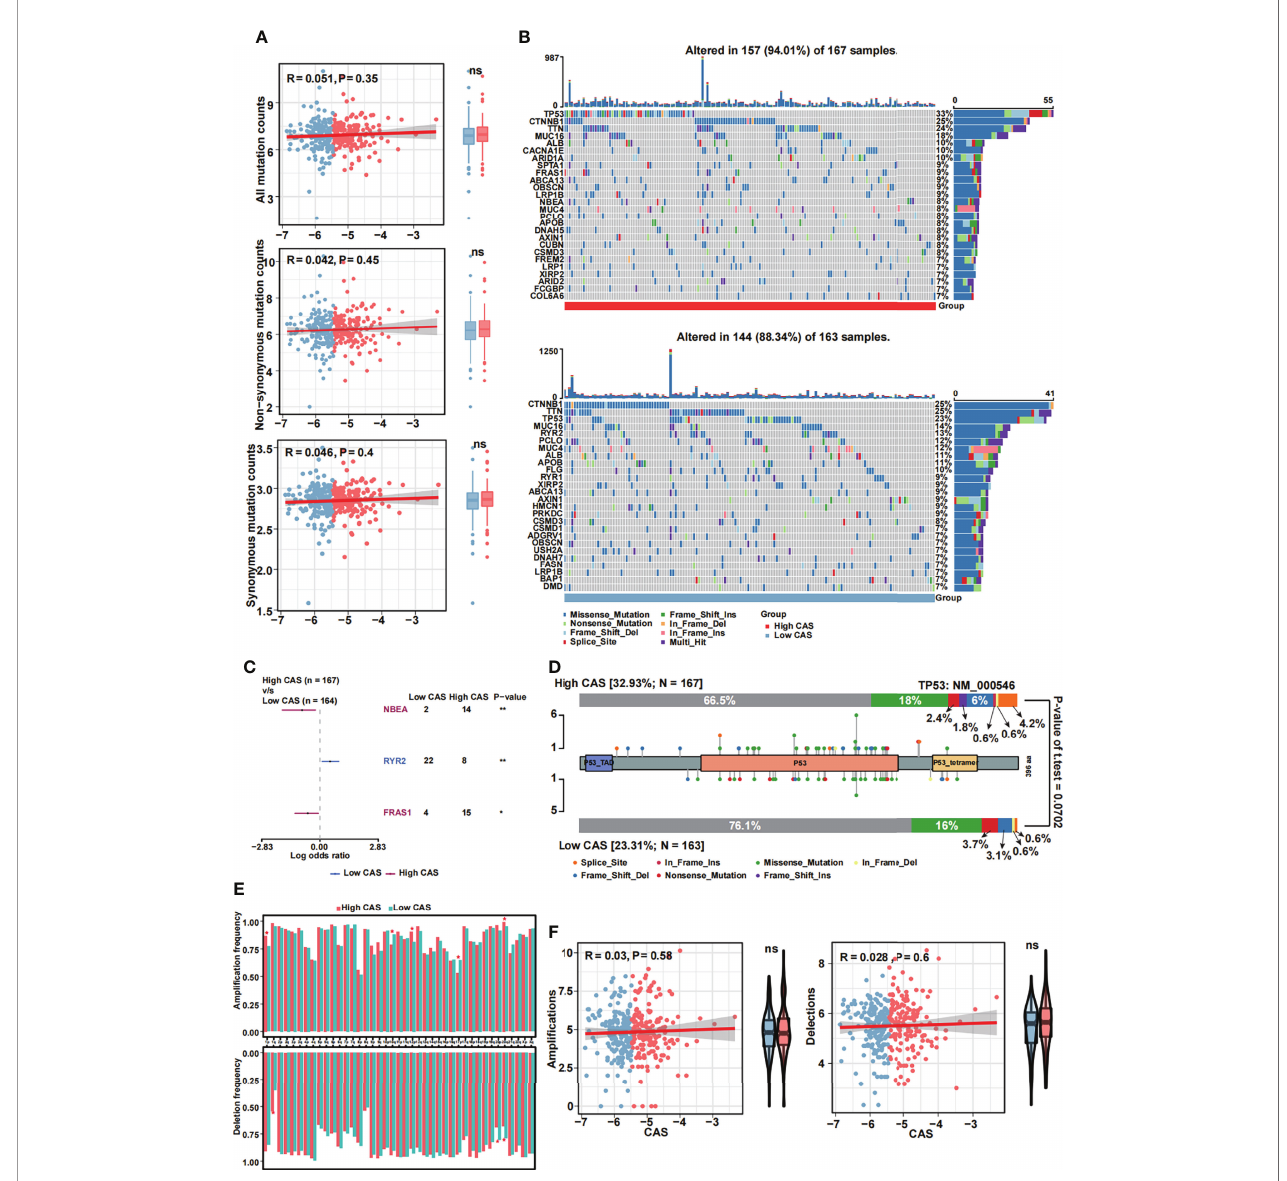
FIGURE 7 | Mutational analyses of the constructed ANN model. (A) The Pearson ’ s correlation analysis between CAS and all mutation, non-synonymous mutation and synonymous mutation counts, and the counts of all mutation, non-synonymous mutation and synonymous mutation in high- and low-CAS samples. (B) Landscape of the 26 mutated genes that had more than 15 mutation counts in high-CAS samples (25) and low-CAS samples (lower). (C) Differentially mutated genes between high- and low-CAS samples. (D) A lollipop chart illustrates the location and the type of mutation in TP53. (E) The ampli fi cation and deletion frequency in each arm between high- and low-CAS samples. (F) The Pearson ’ s correlation between CAFs and ampli fi cation/deletion, and the frequency of ampli fi cation/ deletion in high- and low-CAS samples. *P-value < 0.05; **P-value < 0.01; NS: No Signi fi